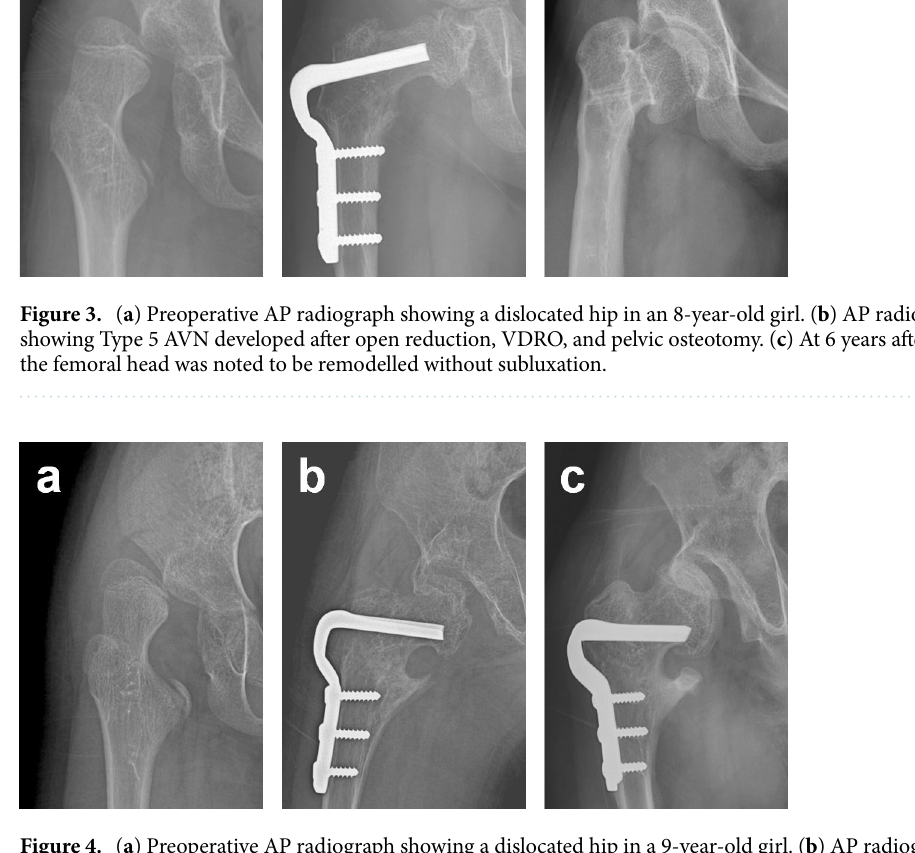
Figure 4. ( a ) Preoperative AP radiograph showing a dislocated hip in a 9-year-old girl. ( b ) AP radiograph showing Type 5 AVN developed after open reduction, VDRO, and pelvic osteotomy. ( c ) At 4 years after surgery, the femoral head failed to be remodelled and the hip was